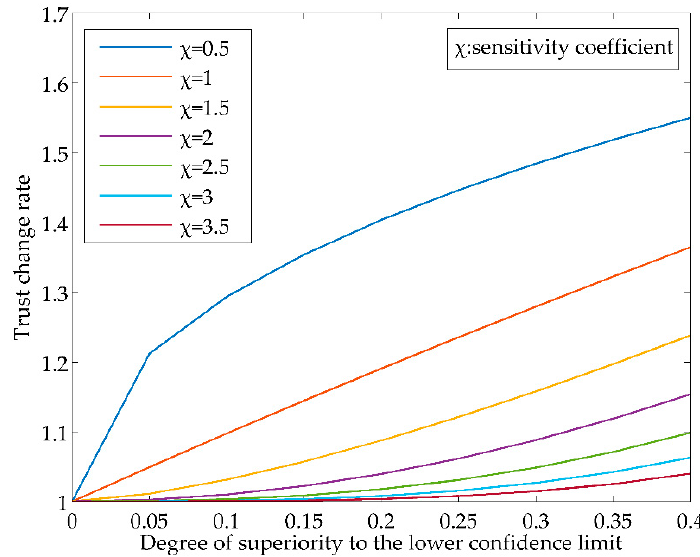
Figure 2. The influence of sensitivity coefficient on trust increase.